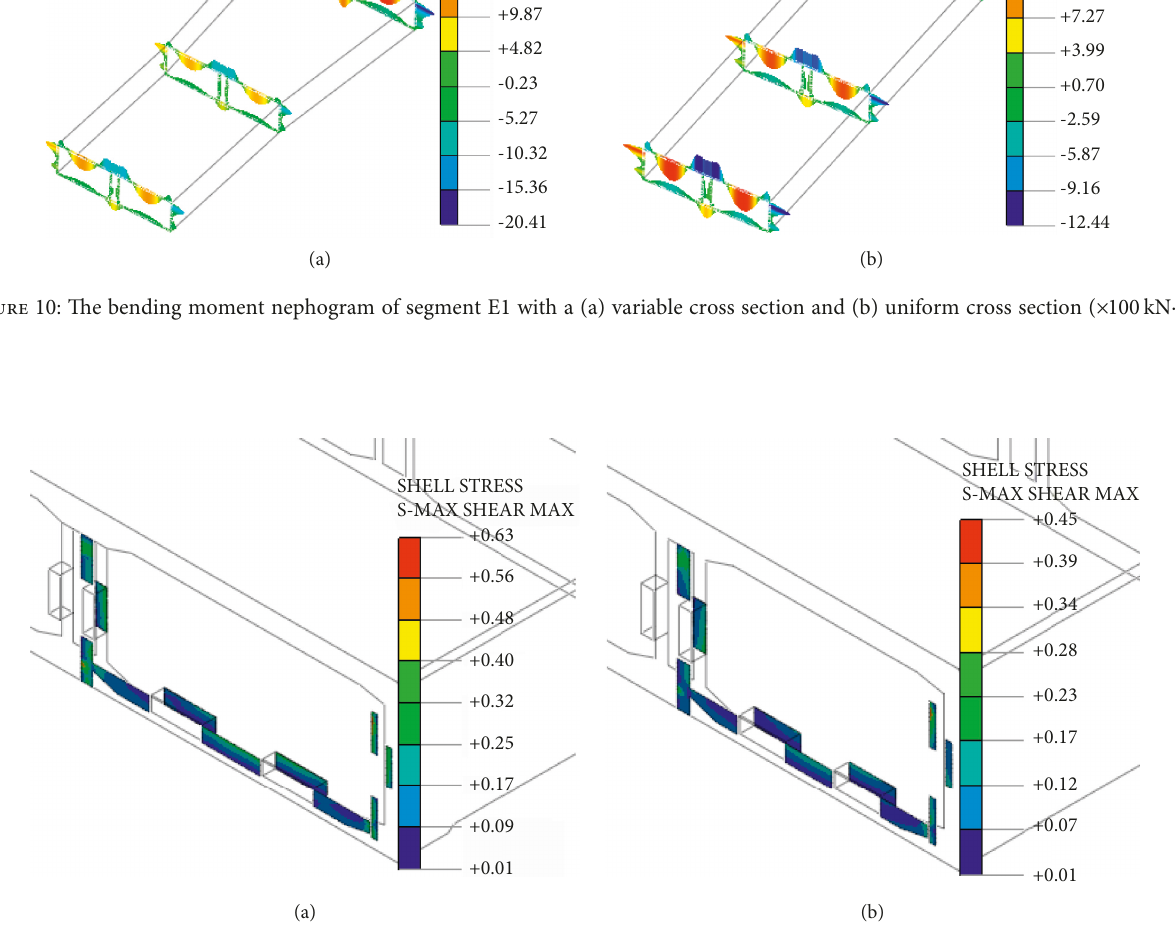
Figure 11: The shear stress nephogram of joint 2 with a (a) variable cross section and (b) uniform cross section